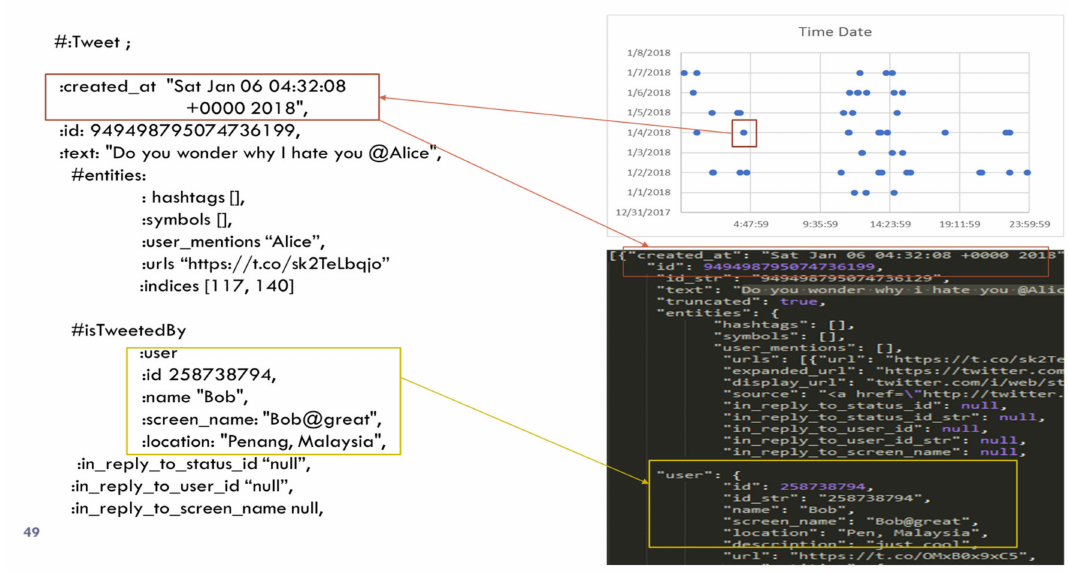
Figure 12. Links from evidence to the